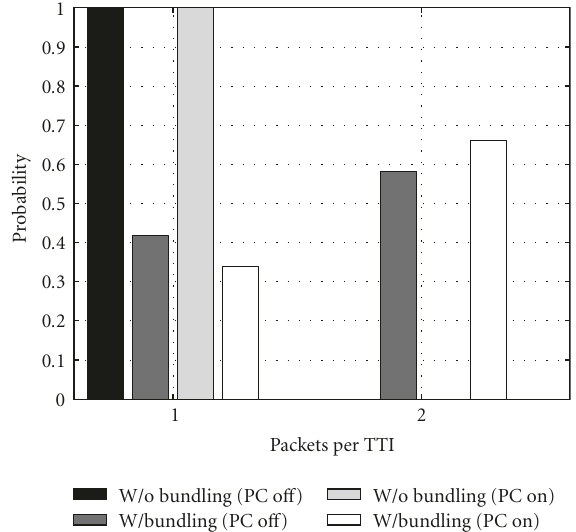
Figure 8: Distribution of the number of transmitted packets to each user per TTI (Macro Case